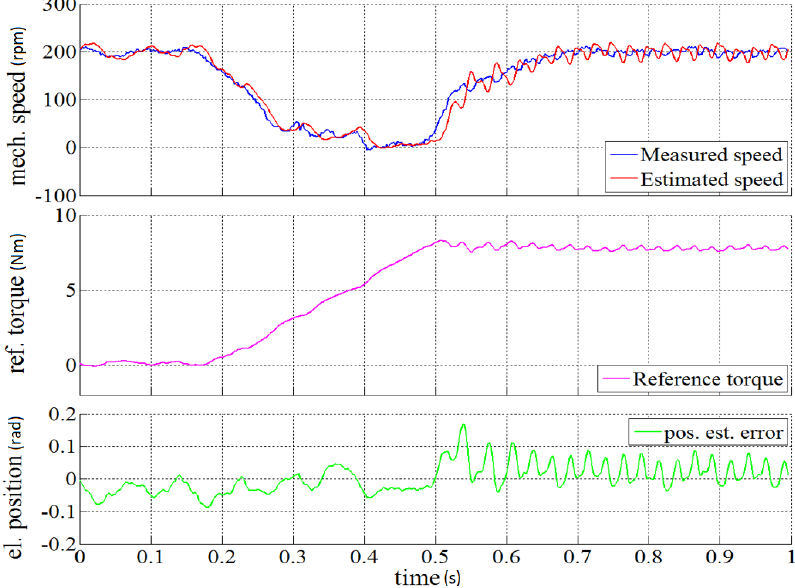
Figure 13. Motor #1: Sensorless speed control (MTPA), load disturbance at 200 rpm, 0 to 6 Nm load, proposed (self-adaptation) rotating voltage injection.